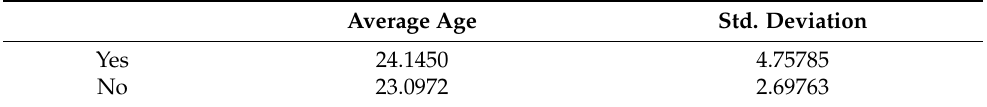
Table 3. Age and decision to